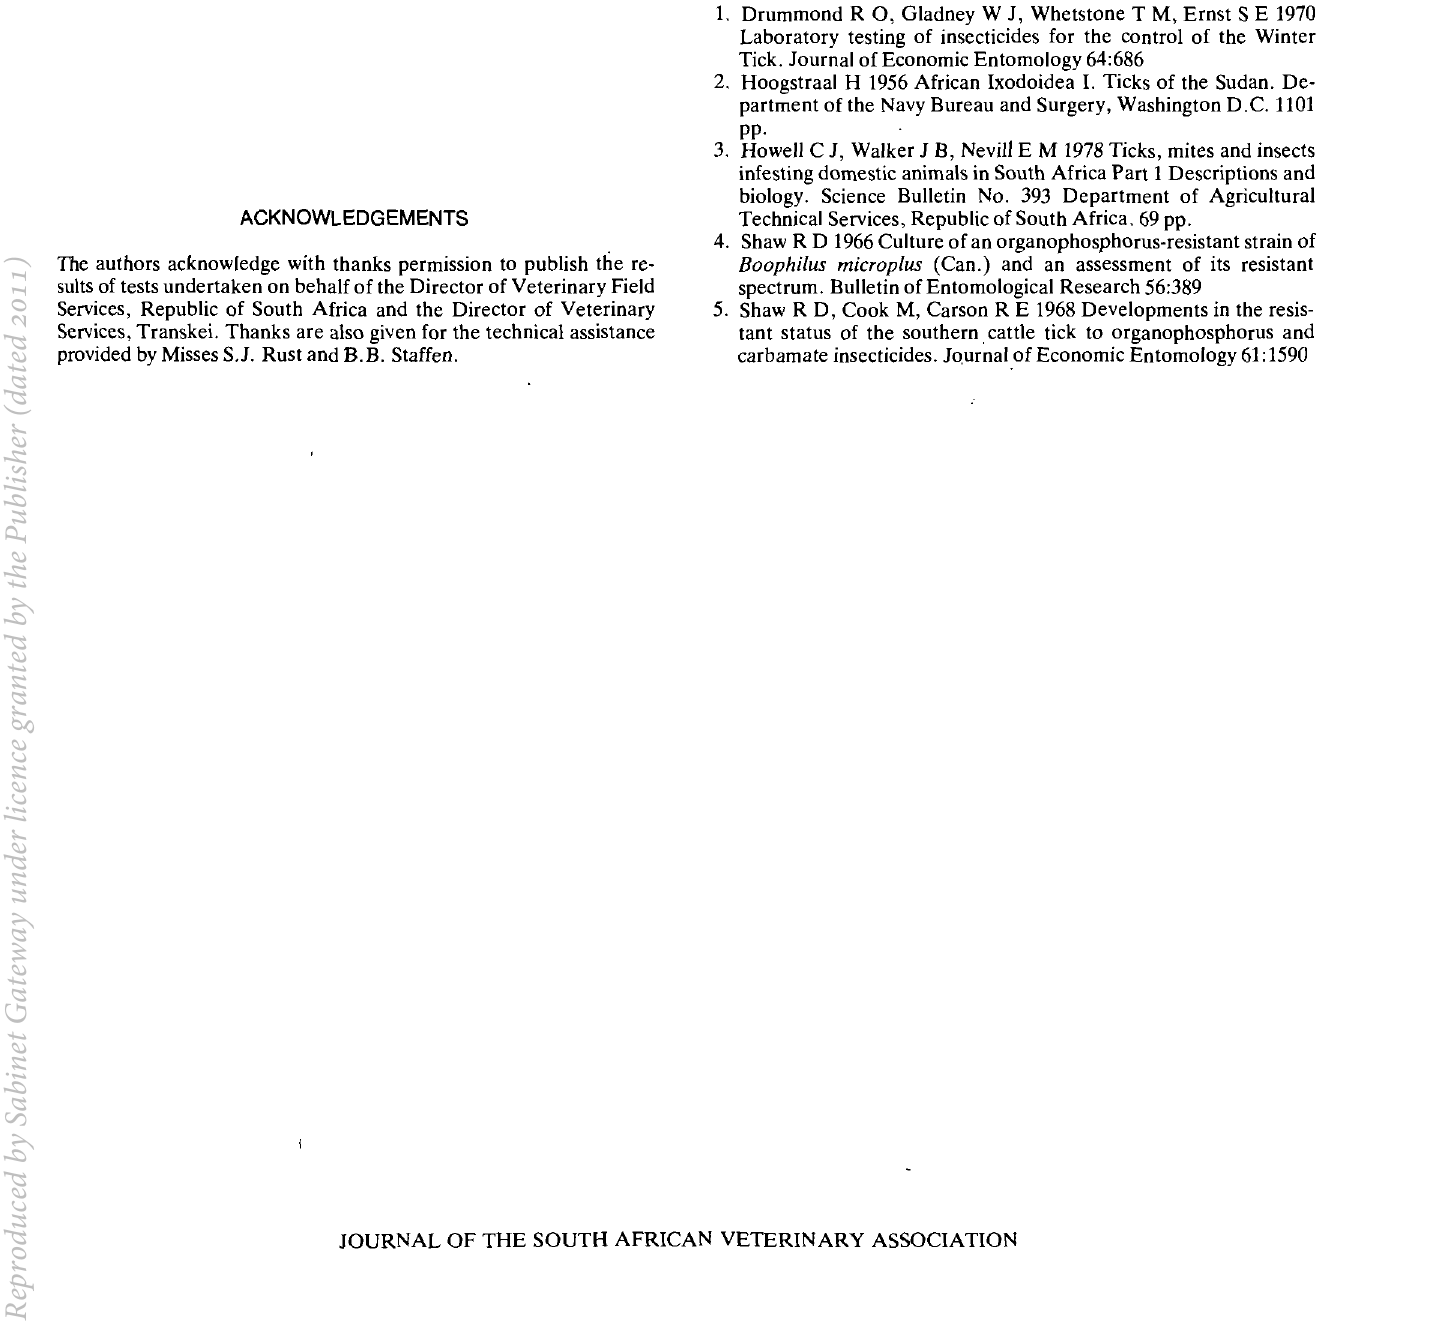
Fig. 4. A comparison of the effect of a range of test concentrations of three different ixodicides on engorged females of two strains of Boophilus microplus.